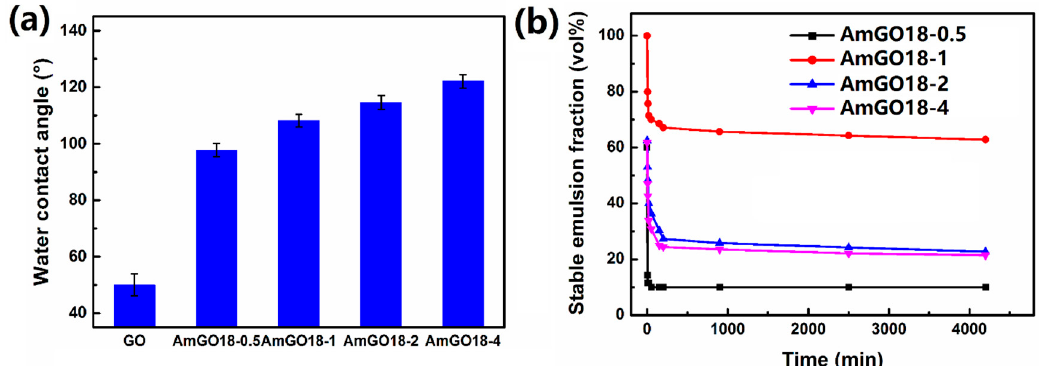
Figure 4. ( a ) Water contact angles of GO and AmGO; ( b ) Change in the volume fraction of the residual emulsion as a function of time for the emulsions stabilized by AmGO18-0.5, AmGO18-1, AmGO18-2 and AmGO18-4. AmGO concentration: 1 mg/mL. Toluene/water ratio: 1:1.